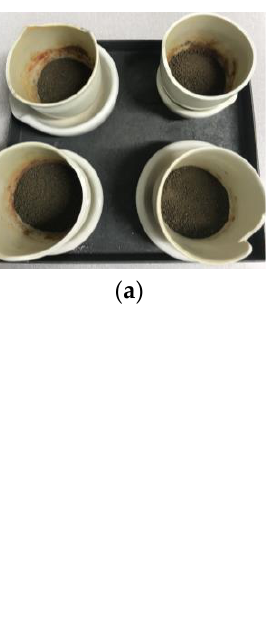
Table 3 . Characterizations of char residues obtained from the pyrolysis of Lidköping and Borås sewage sludge.